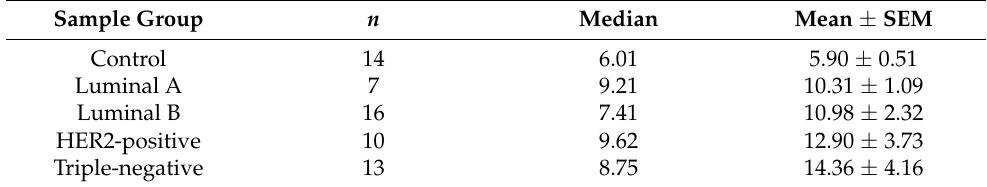
Table 2. Serum VISTA levels (pg/mL) in healthy cats and animals diagnosed with mammary tumors, grouped according to the molecular